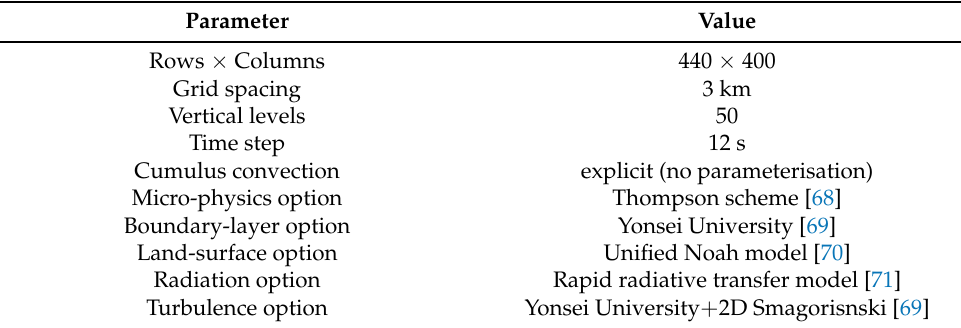
Table 1. Basic settings of the WRF model